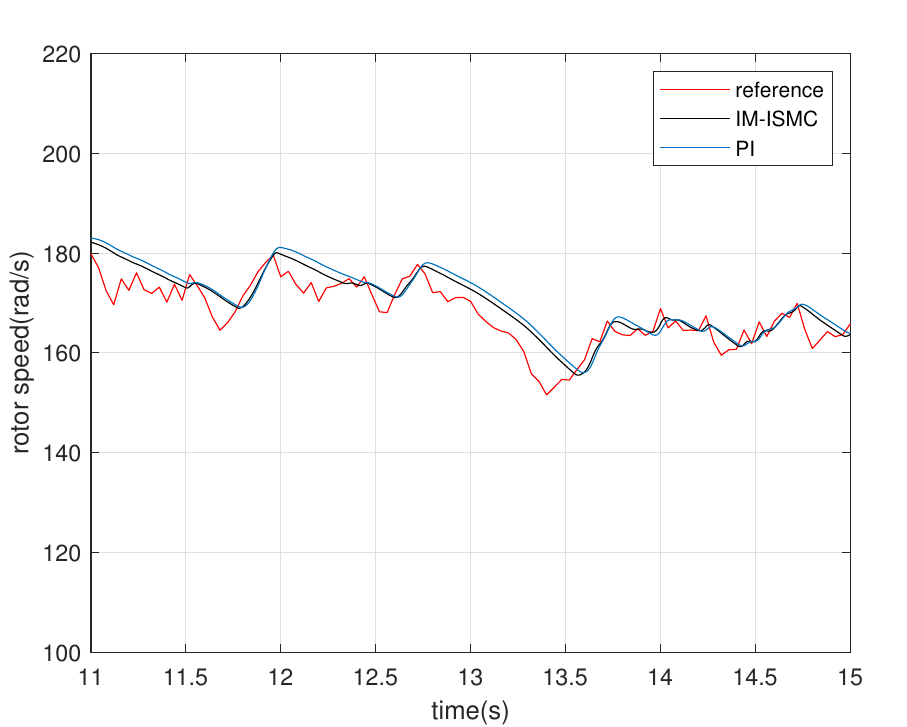
Figure 16. Rotor speed 11–15 s enlarged view. Figure 17 shows the corresponding reactive power curves of the two controllers. The reference value of reactive power is 0 W. The proposed controller can converge